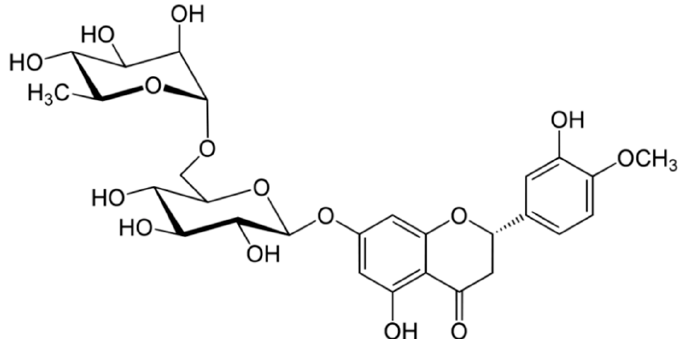
Figure 13. Structure of hesperidin .